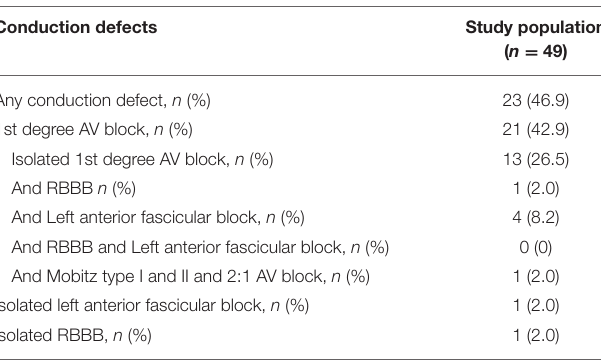
TABLE 4 | Echocardiography data for congenital DM1 patients. Echocardiography